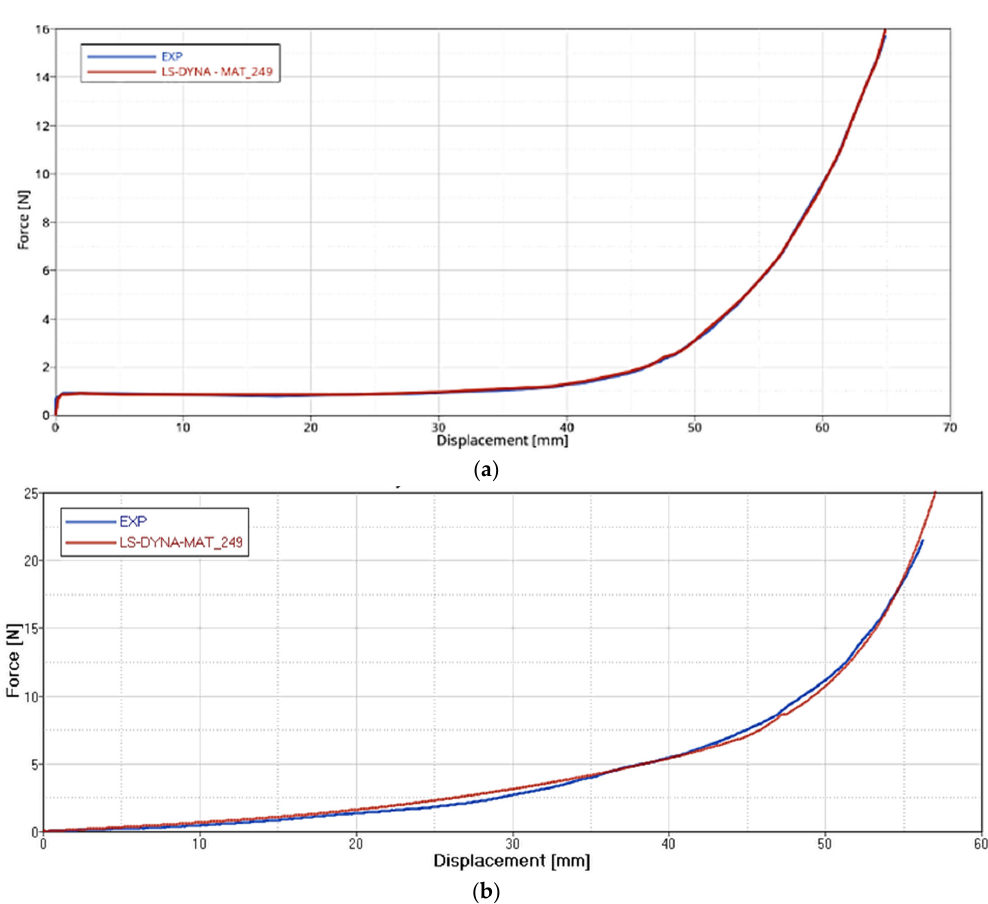
Figure 25. FEA-experimental correlation of the Shear test on GF ( a ), CF ( b ) dry fabrics.